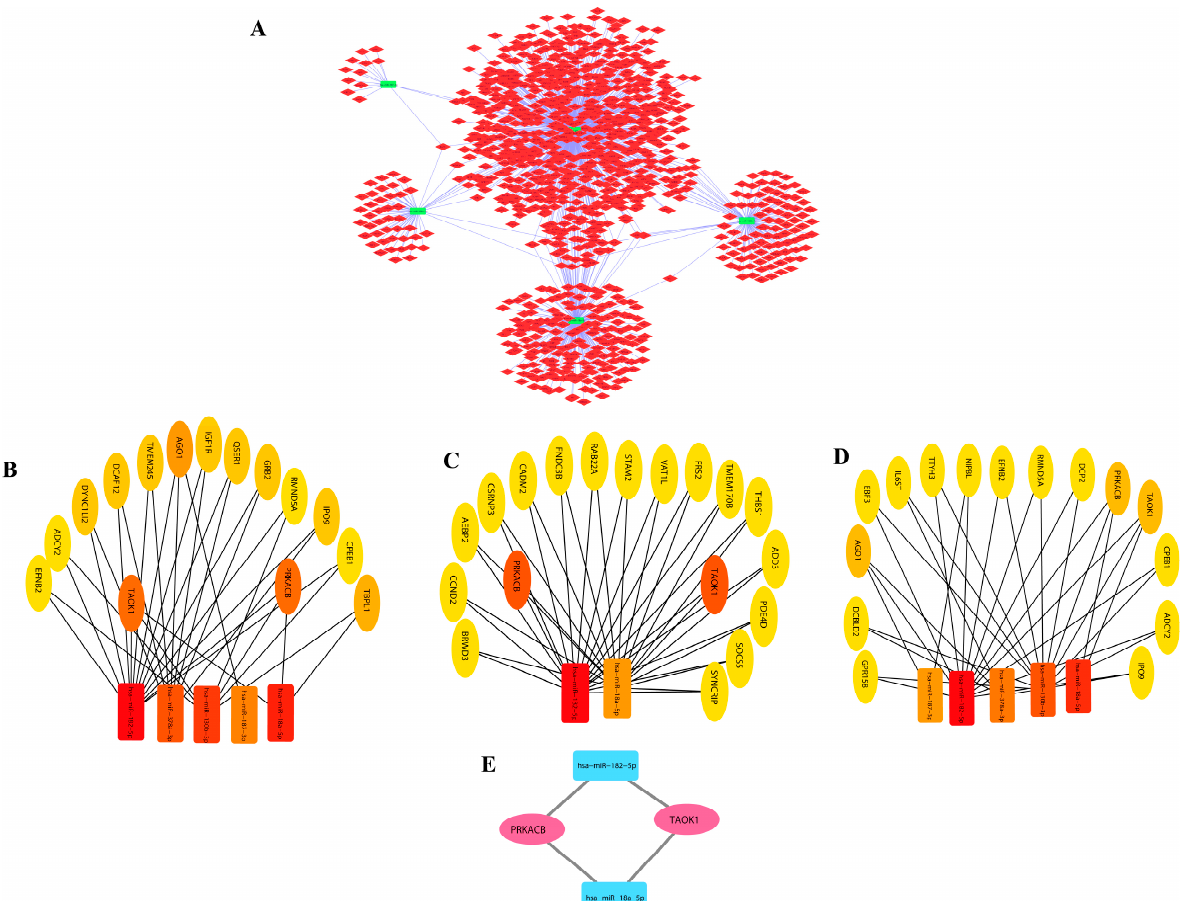
Figure 3. (A) Upregulated network of miRNAs and their associated target genes . The associated genes were further identified on the basis of centrality measures. (B) On the basis of betweenness. ( C) On the basis of closeness. (D) On the basis of degree. (E) Common genes obtained from signifi- cant